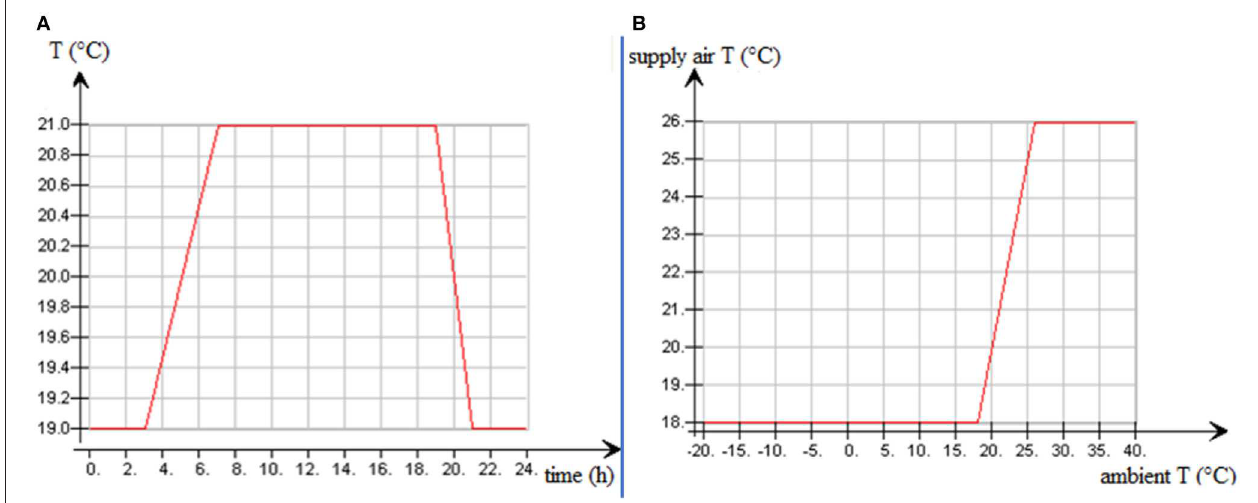
with a certain set points as described below. The used control method is always the